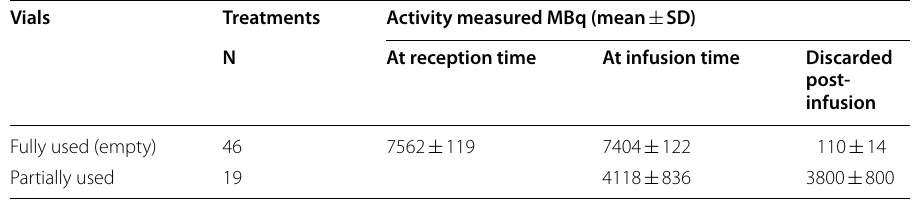
Table 1 Data for the 65 Lutathera ® vials used for the first treatments administered Vials